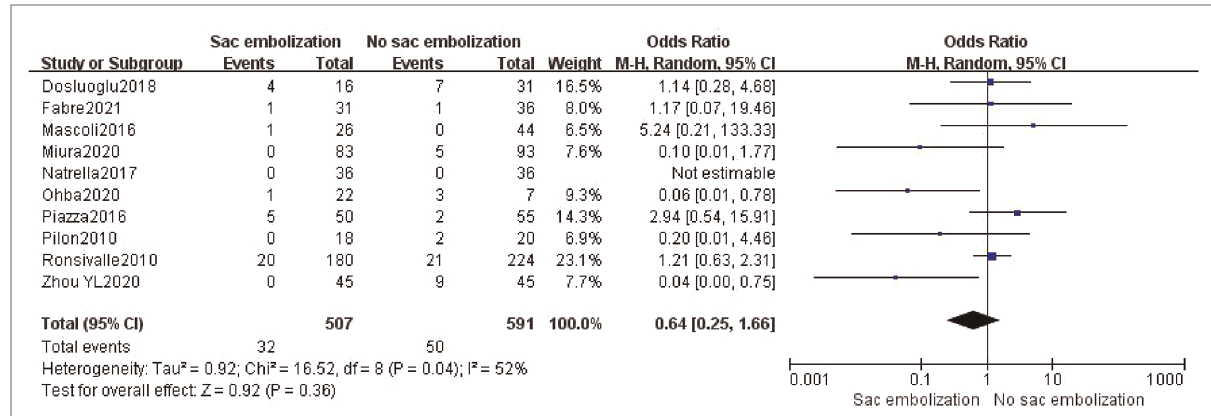
FIGURE 6 Mortality in the embolization group compare with the non- embolization group.